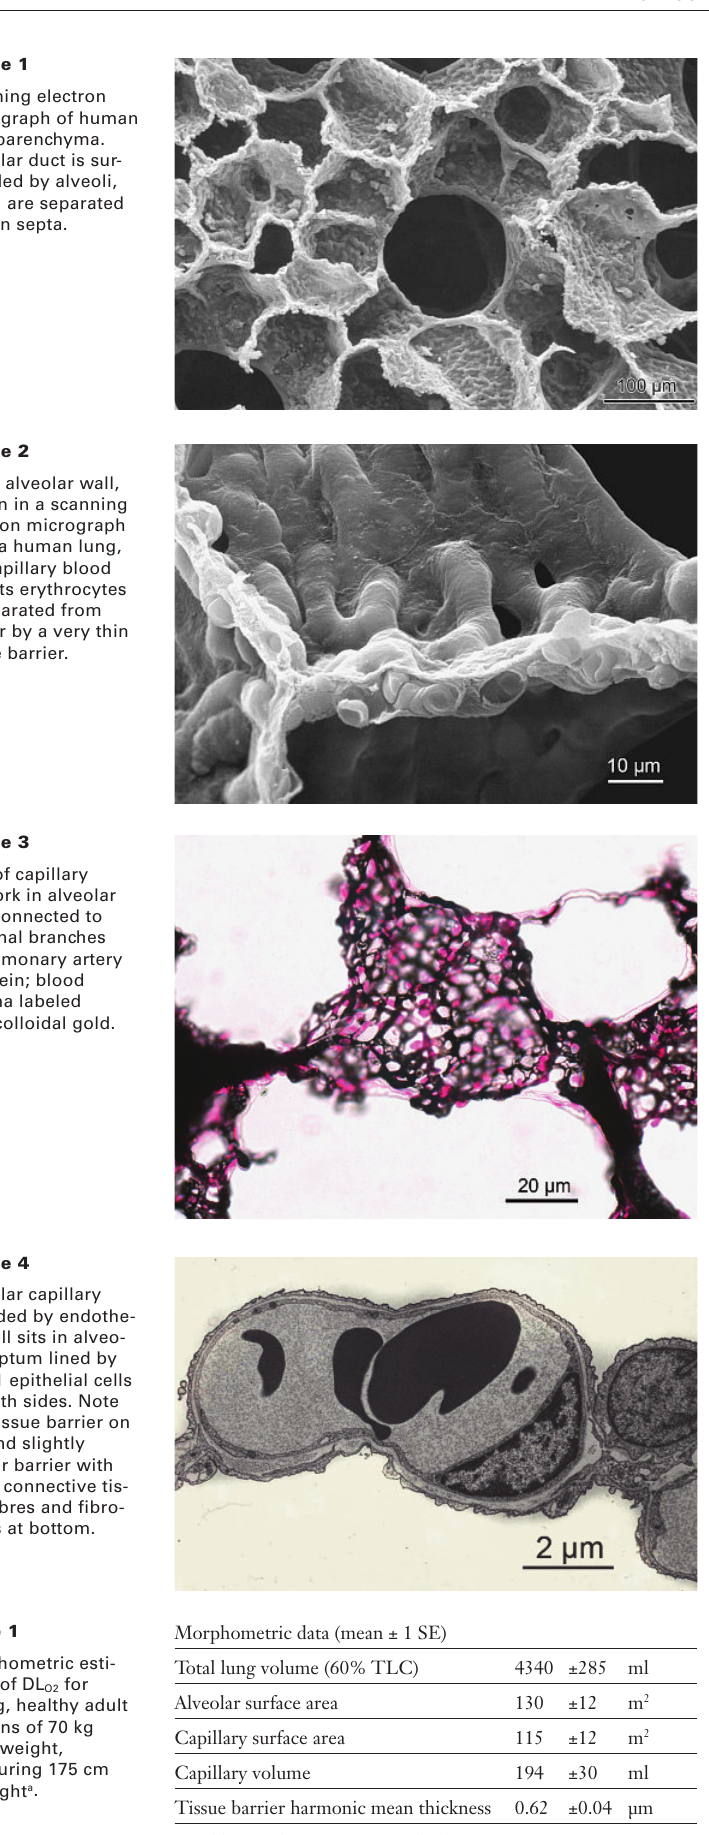
Scanning electron micrograph of human lung parenchyma. Alveolar duct is sur- rounded by alveoli, which are separated by thin septa.